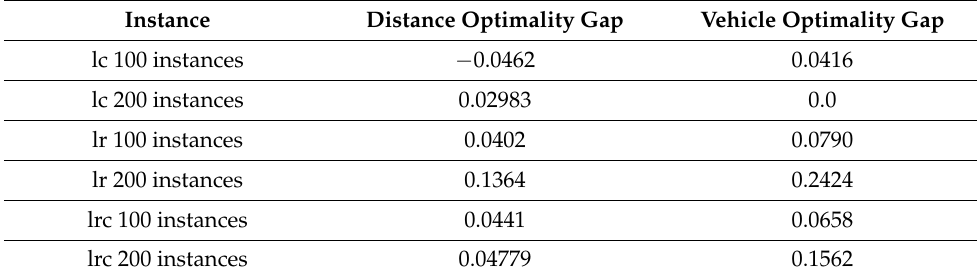
Table 3. Summary on Li-Lim